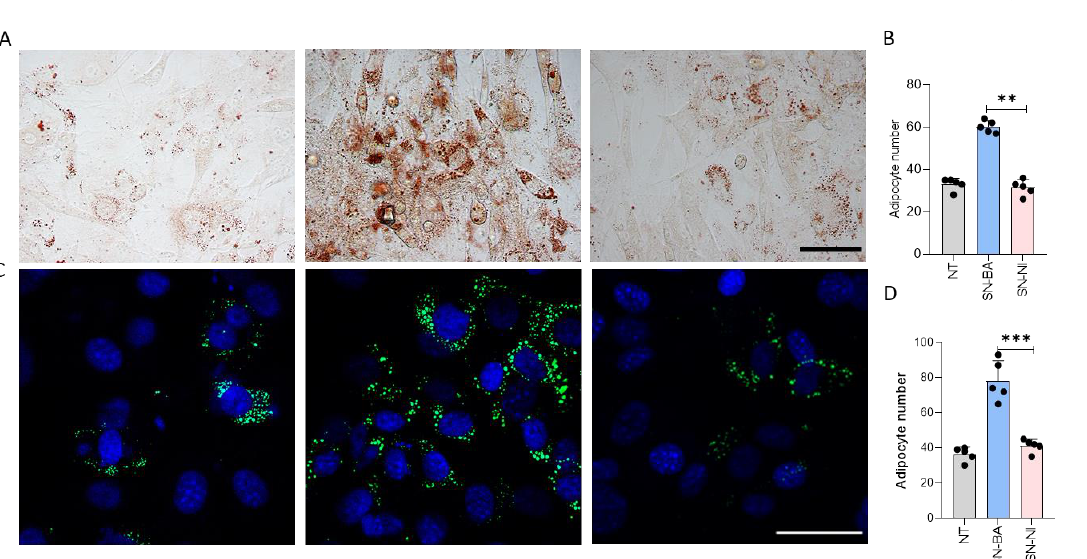
Figure 7. Culture supernatants from B. abortus -infected osteoblasts induce adipogenesis. Effect of culture supernatants from B. abortus -infected osteoblasts on adipocyte differentiation determined by lipid droplet staining with Oil Red O ( A ), quantified by cell counts (44,940 µ m 2 ) ( B ) and Bodipy 493/503 staining (24,000 µ m 2 ) ( C ), quantified by cell counts ( D ). NT: non-treated. Scale bar: 50 µ m. ** p < 0.001, and *** p < 0.0001 vs. cells treated with culture supernatants from non-infected cells (SN-NI).